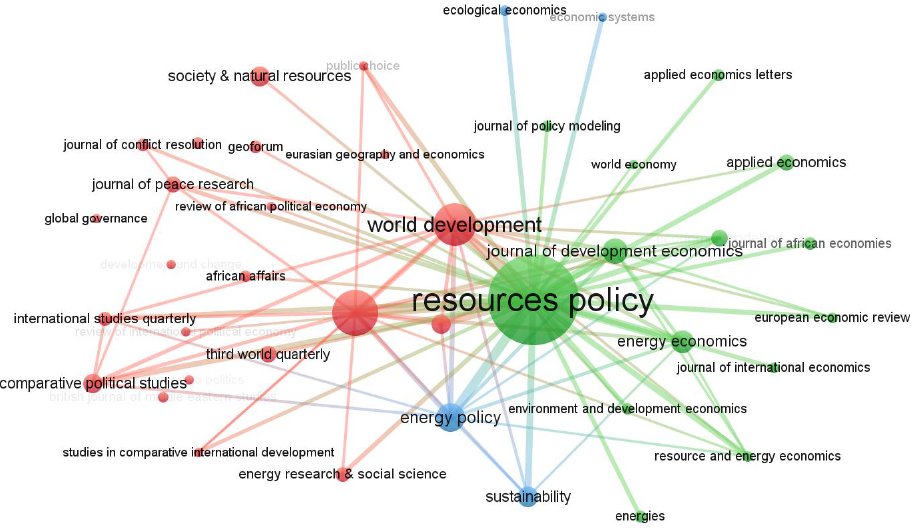
Figure 14. The consortium of eminent journals.